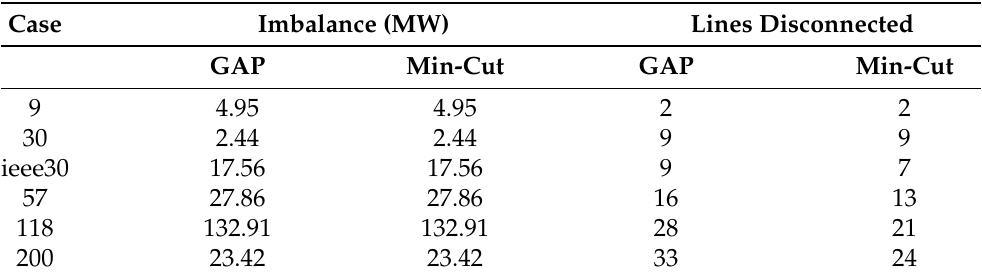
Figure 6. Clustering visualisation of the results obtained by using the min-cut loss function. Each color represents a specific cluster. The first row displays the results from case 14, followed by case 30 and case 118. Table 2. Numerical results of the proposed methods for test cases 9, 30, ieee30, 57, 118, and 200.